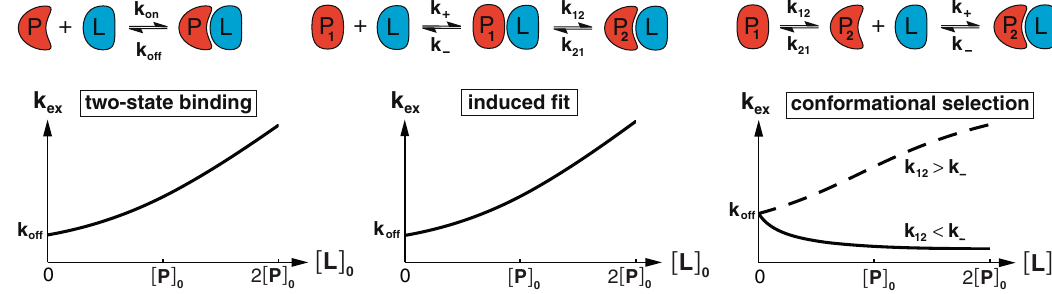
Fig. 1 Concentration dependence of exchange rates in two-state and three-state binding mechanisms. Exchange rate k ex for residues of the protein P as a function of the total concentration [ L ] 0 of the ligand L in two-state binding, in three-state binding via induced fi t, and in three-state binding via conformational selection. In the three-state binding models, the protein exhibits two conformations P 1 and P 2 . In two-state binding and induced fi t, k ex increases with [ L ] 0 . In conformational selection, k ex decreases with increasing [ L ] 0 if the conformational excitation rate k 12 is smaller than the unbinding rate k − and increases with [ L ] 0 if k 12 is larger than k − . The exchange rate for two-state binding (TS) is k TS selection (CS) are the dominant relaxation rates k IF these three-state mechanisms with S = k 12 + k 21 + k + [ L ] eq + k − . The equilibrium concentration [ L ] eq of the unbound ligand is related to the total concentrations [ P ] 0 and [ L ] 0 of protein and ligand via ½ L (cid:2) eq ¼ 1